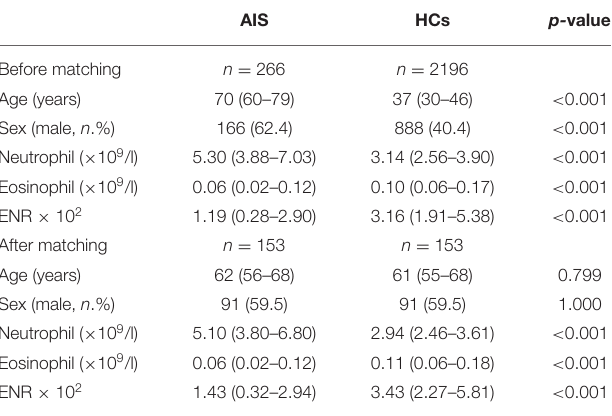
TABLE 1 | Demographic and laboratory characteristics of AIS patients and healthy controls.